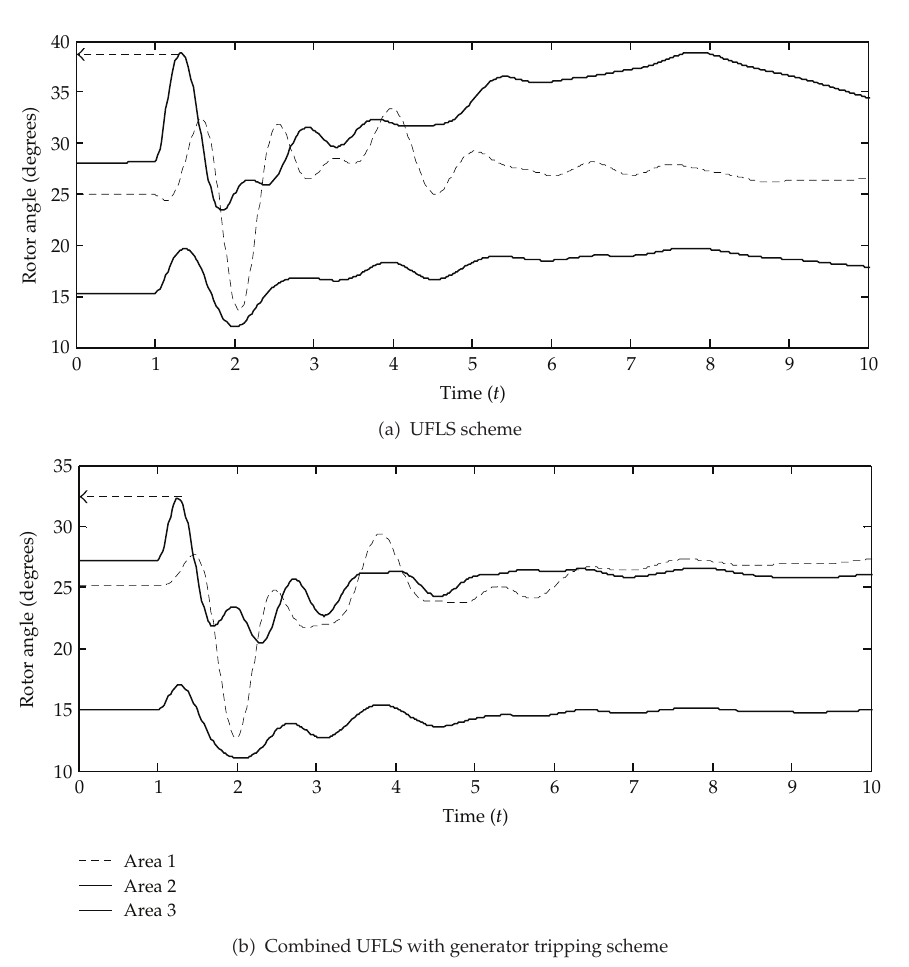
Figure 15: The system remains stable when both schemes are applied.